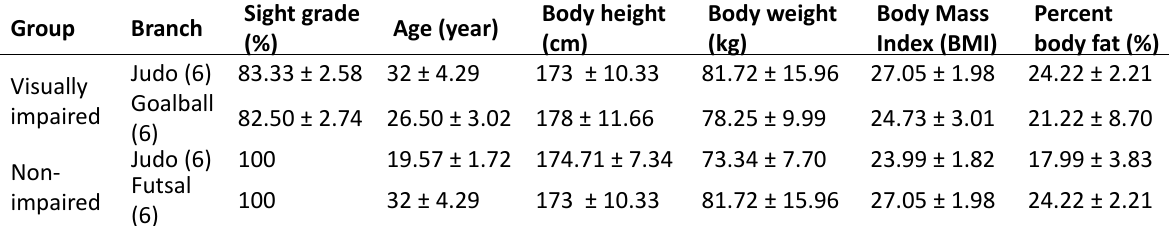
Table 1. Demographic characteristics of the participants. Group